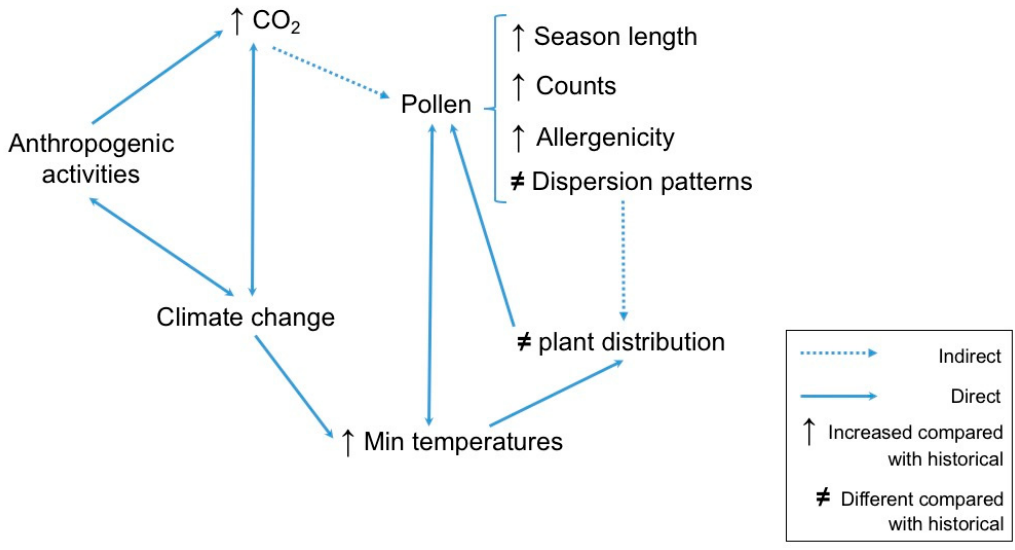
Figure 5. Effects of climate change on aeroallergens.